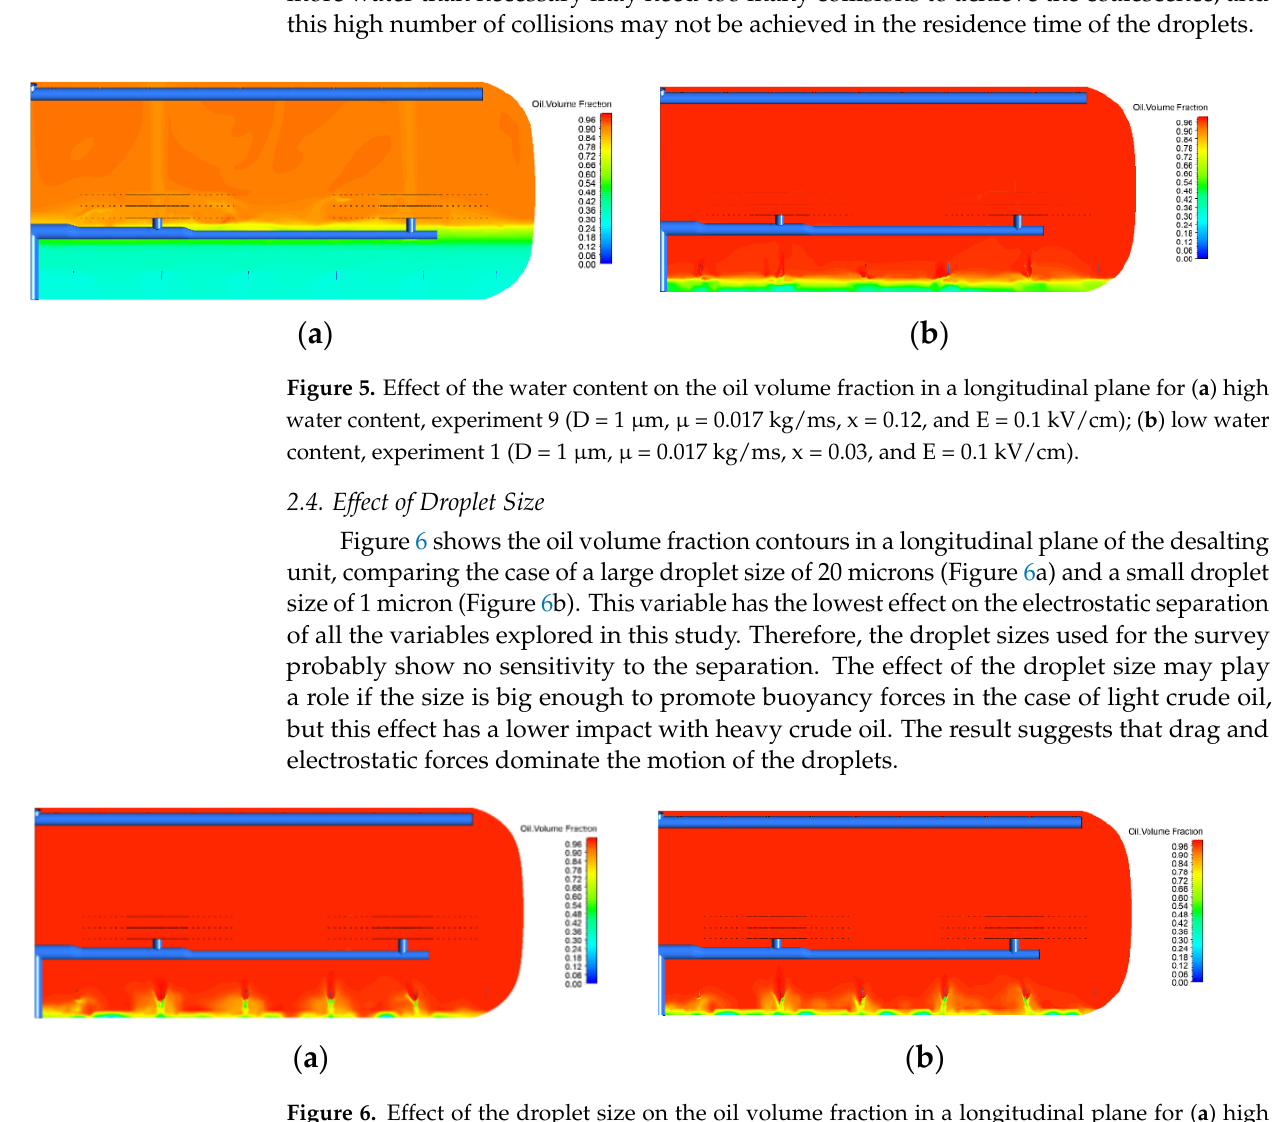
( b ) Figure 3. Effect of the electric field on the oil volume fraction in a longitudinal plane for ( a ) high electric field, experiment 11 (D = 1 µm, µ = 0.071 kg/ms, x = 0.12, and E = 3 kV/cm); ( b ) low electric field, experiment 15 (D = 1 µm, µ = 0.071 kg/ms, x = 0.12, and E = 0.1 kV/cm). 2.2. Effect of Temperature (Oil Viscosity) Figure 4 shows the oil volume fraction contours in a longitudinal plane of the desalt- ing unit, comparing the case of high oil viscosity (low temperature) of 0.071 kg/ms (Figure 4a) and low oil viscosity (high temperature) of 0.017 kg/ms (Figure 4b). This variable has a lower effect on the electrostatic separation than the electrostatic field, but the influence is still evident. Crude oil desalting and dehydration at high temperatures (high viscosity of oil) are achieved better than at low temperatures (low viscosity of oil). One of the forces droplets feel that prevents the separation is the drag forces from the oil to the water drop- let, so the higher the viscosity, the higher the drag forces and the worse the separation. ( a ) ( b ) Figure 4. Effect of the temperature (oil viscosity) on the oil volume fraction in a longitudinal plane for ( a ) high viscosity, experiment 12 (D = 20 µm, µ = 0.071 kg/ms, x = 0.12, and E = 0.1 kV/cm); ( b )